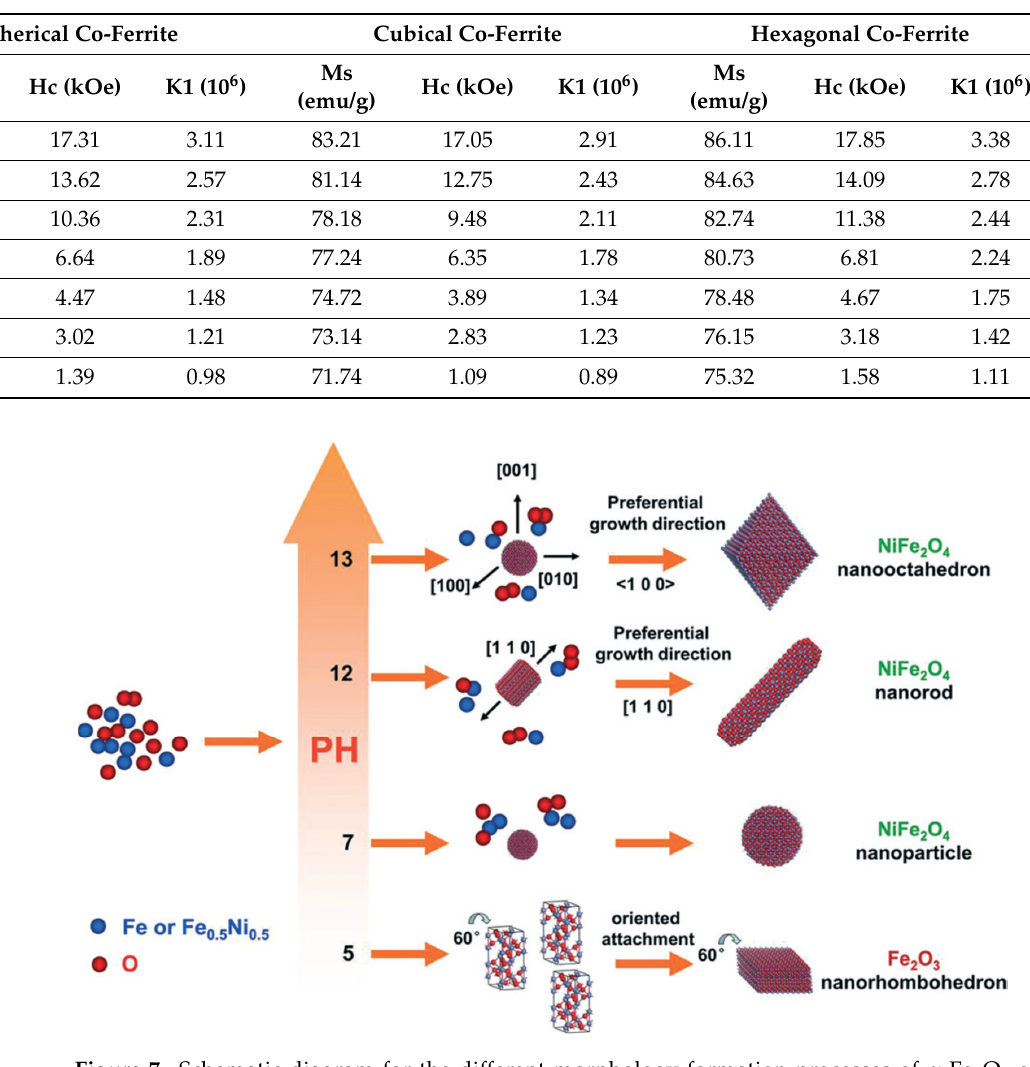
Figure 7. Schematic diagram for the different morphology formation processes of α-Fe 2 O 3 and Ni-ferrite. Reproduced with permission from [64] Copyright (2015) Royal Society of Chemistry.